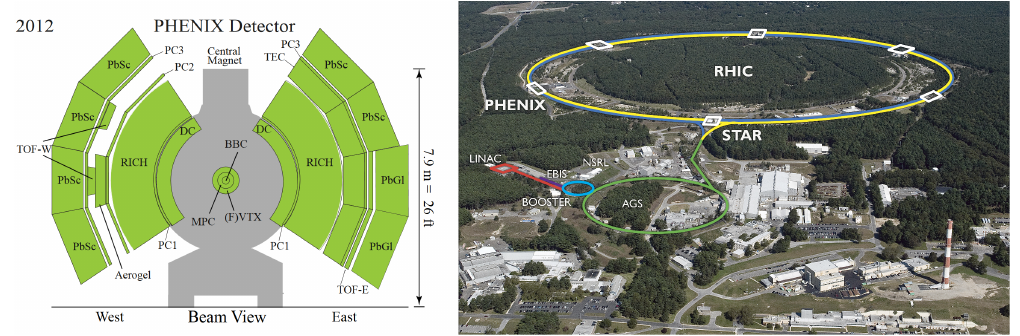
Figure 1. A schematic beam view drawing of the detector system of the accelerator complex at the PHENIX experiment and the RHIC facilities from a bird’s-eye